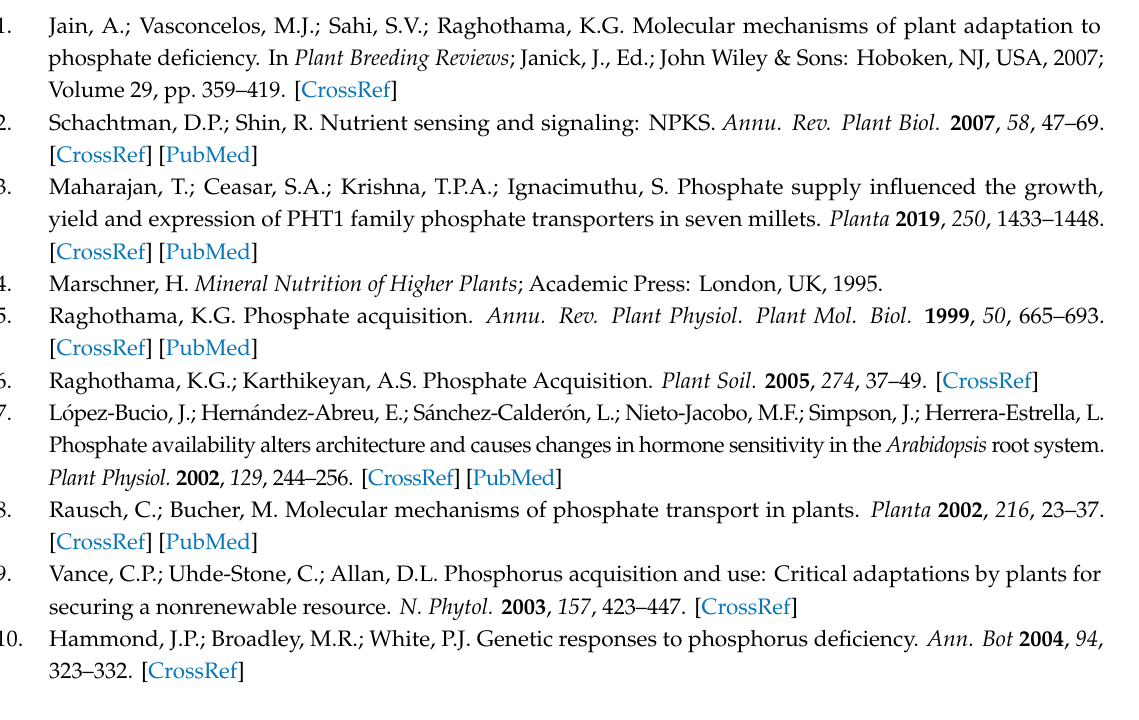
Table S1: Features of the 81 PHT genes identified in Brassica napus ( BnaPHTs ). Table S2: Features of the PHT genes ( PHTs ) in B. napus , Arabidopsis , Brassica rapa and Brassica oleracea. Table S3: Protein domains of PHT proteins in B. napus. Table S4: Transcription factor (TF) binding sites in the promoter regions of BnaPHTs. Table S5: Duplication events of BnaPHTs. Table S6: Homology and expression correlation analysis of 51 sister pairs of BnaPHTs. Table S7: The functionally characterized plant PHTs. Table S8: List of the primers used for the Real-time PCR analyses. Figure S1: The Maximum Likelihood (ML) trees of the candidate PHT proteins from Brassica napus , Arabidopsis , Brassica rapa and Brassica oleracea . Figure S2: The intron pattern of the five PHT families in B. napus , Arabidopsis , B. rapa and B.